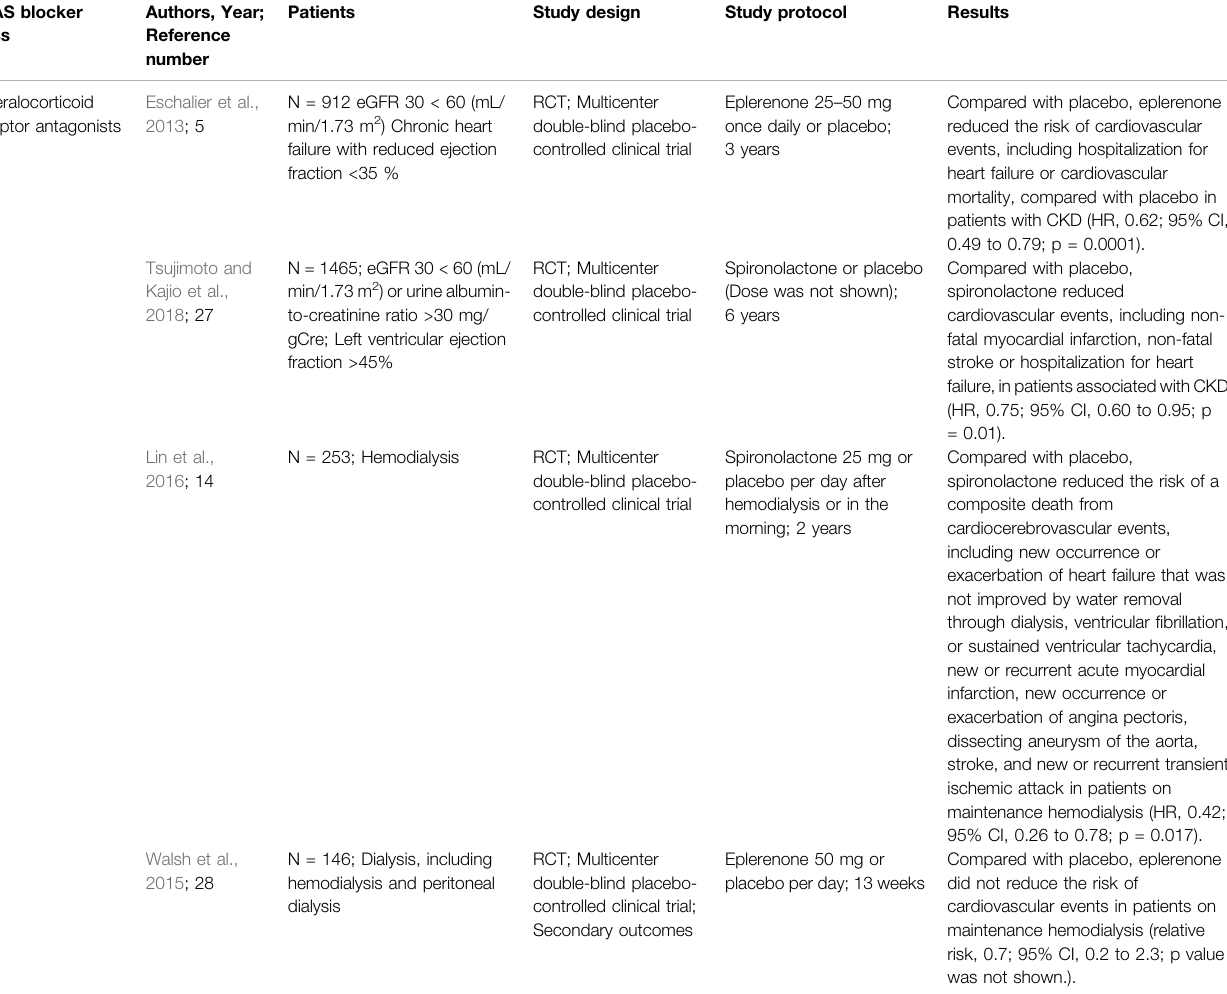
TABLE 2 | Effects of mineralocorticoid receptor antagonists for the development of cardiovascular disease in pre-dialysis or on-dialysis patients with CKD. RAAS blocker